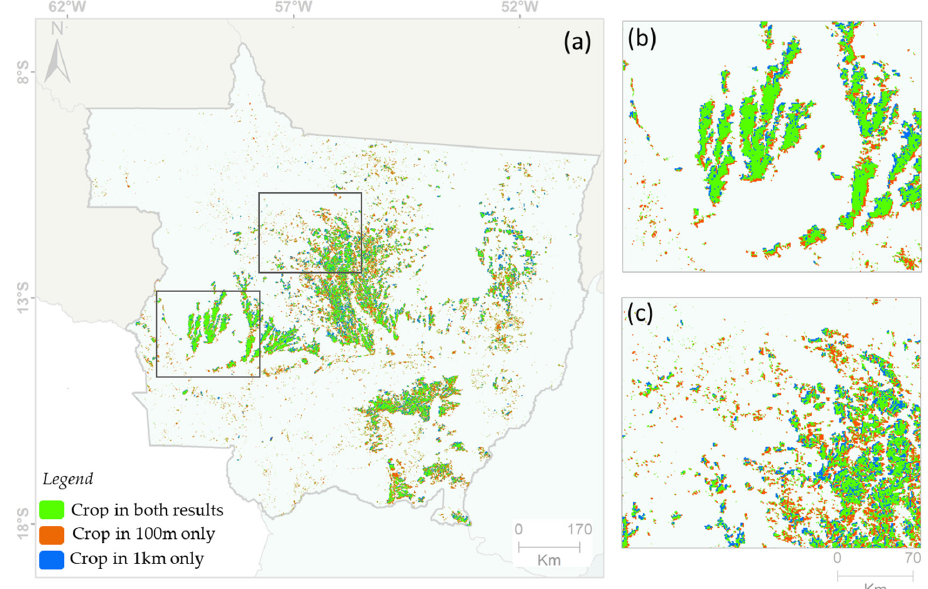
Figure 14. ( a ) The 2015 Mato Grosso State cropland classification derived from PROBA-V data and the comparison with 1 km and 100 m spatial resolutions. Details in ( b ) and ( c